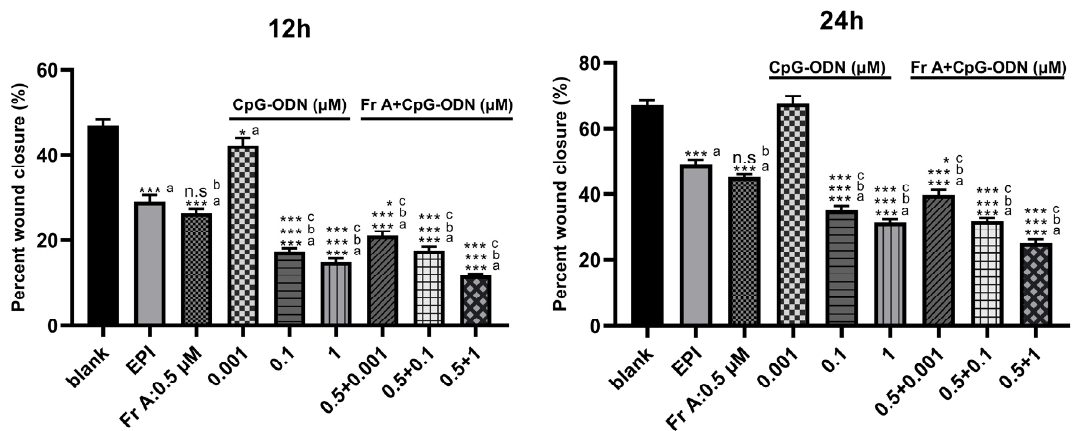
Figure 4. CpG-ODN enhances the inhibition of Frondoside A (Fr A) on UM-UC-3 cell viability and migration. Cells were treated with Frondoside A, CpG-ODN, and Frondoside A combined with CpG-ODN for 24, 48, 72 h. The effects of combinations of Frondoside A and CpG-ODN were tested in parallel with the drugs used alone ( A ). Effects of drugs combination with Frondoside A, and the combinational index (CI) was calculated with the CompuSyn v.1.0. software ( B ). Frondoside A significantly suppressed the migration of UM-UC-3 cells, cell mobility was measured at 0, 12 and 24 h (objective × 4) ( C ), and columns are means; bars are S.E.M. * Significantly different at p < 0.05. *** Significantly different at p < 0.001. n.s (not significant). “a” stands for versus blank control; “b” stands for versus EPI (10 µ M); “c” stands for versus Frondoside A (0.5 µ M)